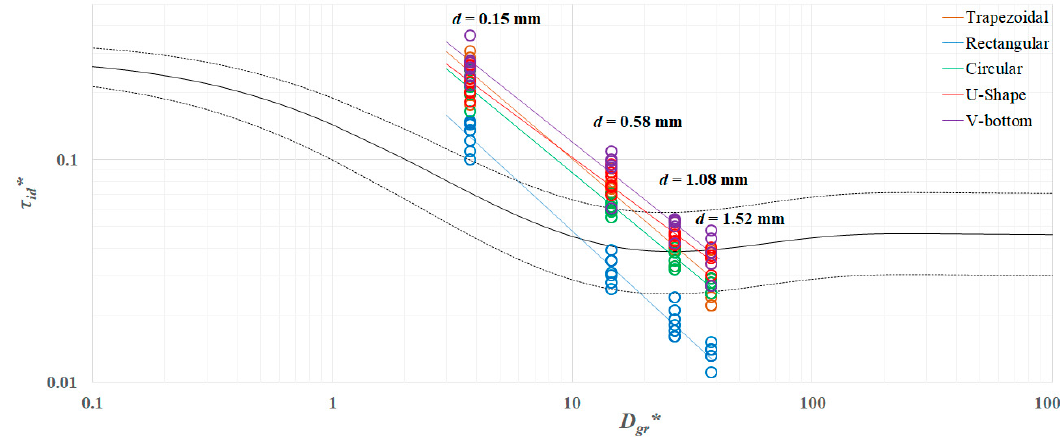
Figure 4. Relationship between the incipient deposition shear stress and grain size based on the Yalin method (circles show values calculated from the measurements, lines are the fitted equations).